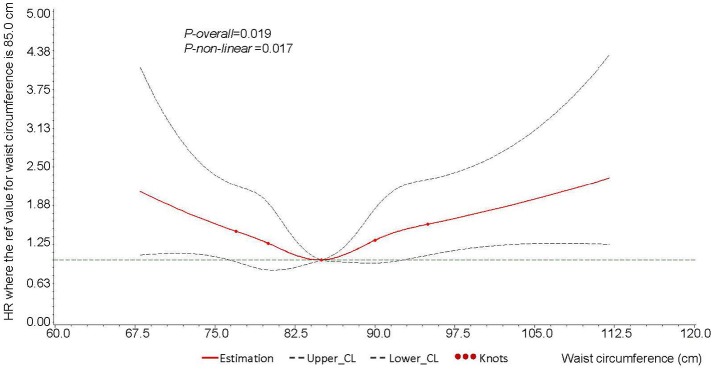
Cubic spline graph of the adjusted HR (represented by solid line) and 95%CI (represented by the dotted lines) for the association between waist circumference and risk of male liver cancer in Kailuan male cohort, 2006–2015.Knots: 77.0, 80.0, 85.0, 90.0, 95.0 of the distribution of waist circumference (cm).Referent: 85.0 cm, 40th of the distribution of waist circumference.Adjusted for age (continuous), education level (illiteracy/primary school, junior high school, senior high school, or college and above), dust exposure (no or yes), smoking (non-smoker, ex-smoker, or current smoker), drinking (non-drinker, ex-drinker, < 1 time per day, or ≥1 time per day), diabetes (no or yes), HBsAg (negative or positive), and BMI (continuous). HR, hazard ratio; HBsAg, hepatitis B surface antigen; BMI, body mass index.